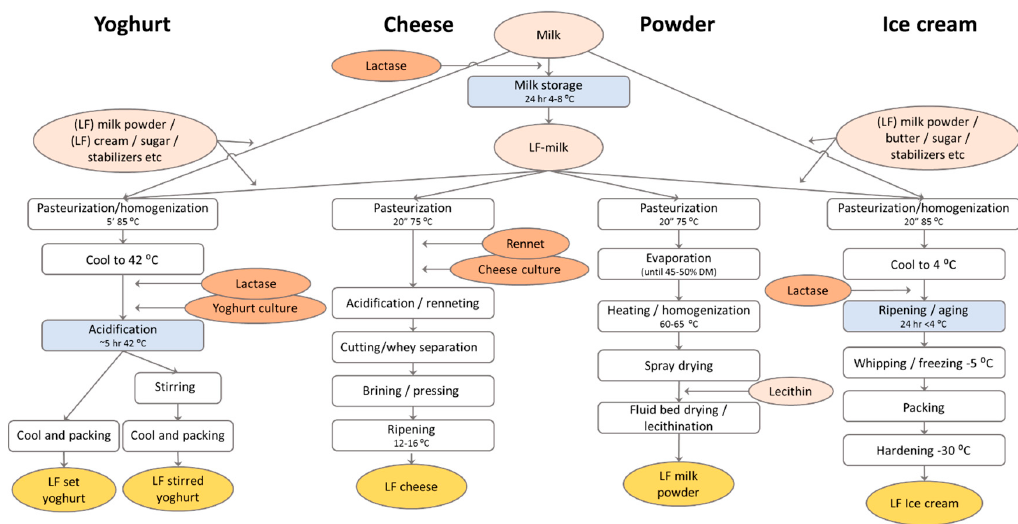
Figure 3. A flow scheme for the production of different lactose-free (LF) dairy products: The process conditions may vary from one factory to another, and additional process steps and additions are commonly included. All products can be made from LF-dairy ingredients, but yoghurt and ice cream may also be treated with lactase in the process. The process steps where lactose hydrolysis can take place are indicated in blue.